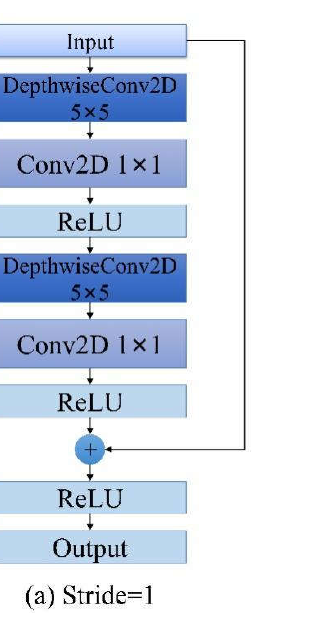
Figure 7. Structure of Double BlazeBlock module.